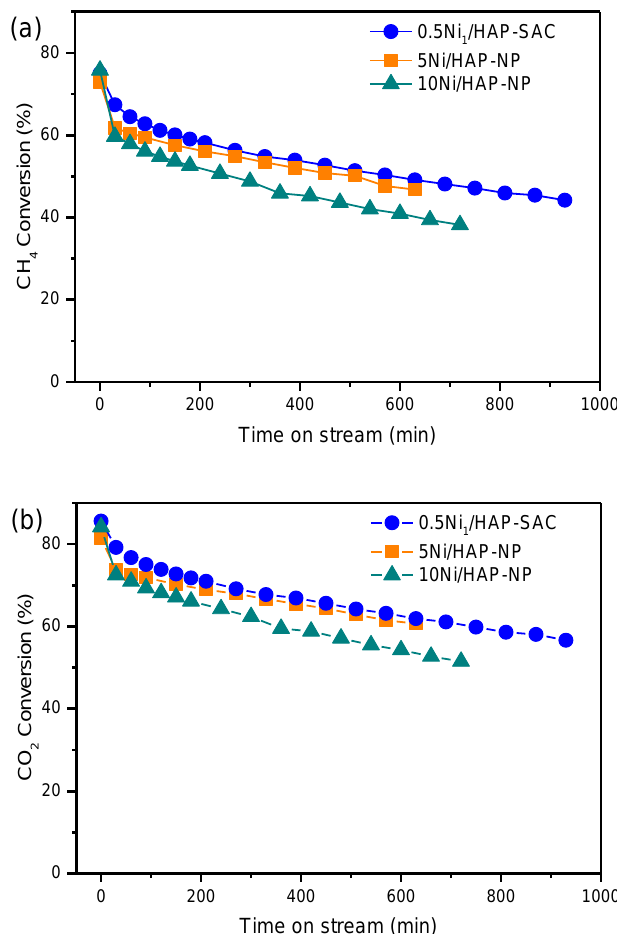
Figure 7. ( a ) CH 4 conversion during DRM over HAP supported Ni single-atom and nanoparticles catalysts, ( b ) CO 2 conversion during DRM over HAP supported Ni single-atoms and nanoparticles catalysts. (All the experiments have been performed at similar metallic gas hourly space velocity: (MGHSV = 12 × 10 6 mL g Ni−1 h −1 ).